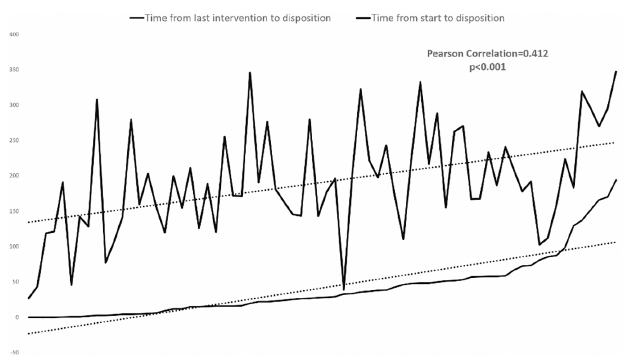
Fig 1. Time from last intervention to disposition versus Time from start to